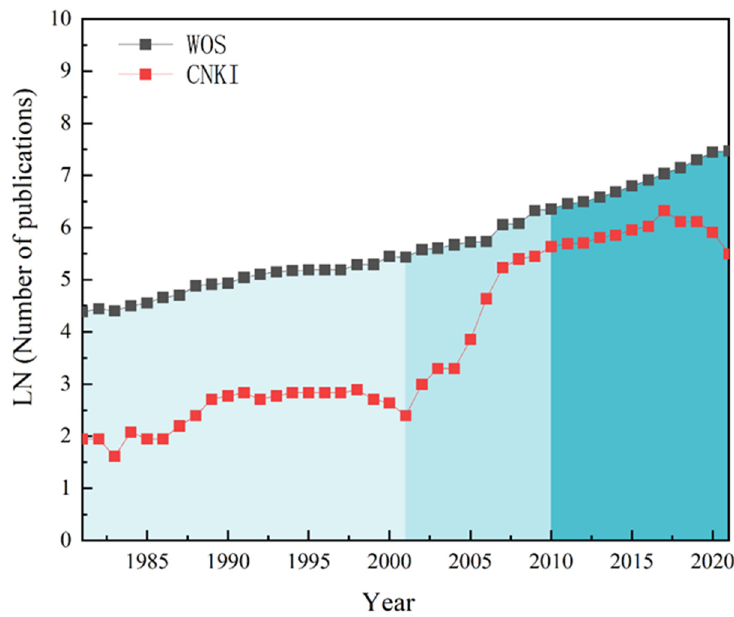
Figure 1. Annual distribution of crop–livestock system research for the period 1981 ‒ 2021.